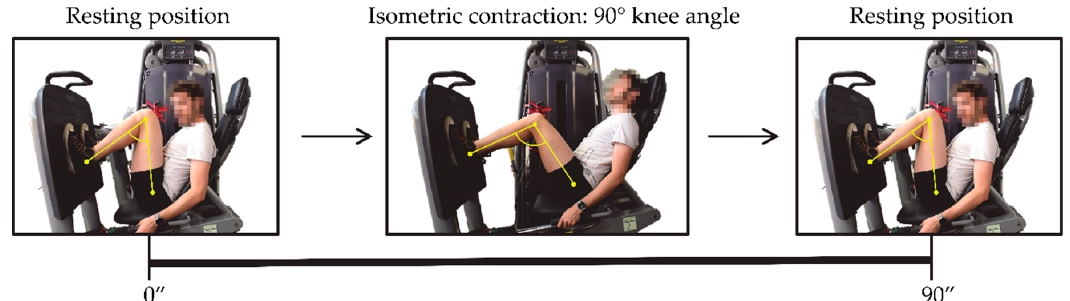
Figure 2. Control position of the volunteers while performing the isometric contraction of the rectus femoris.